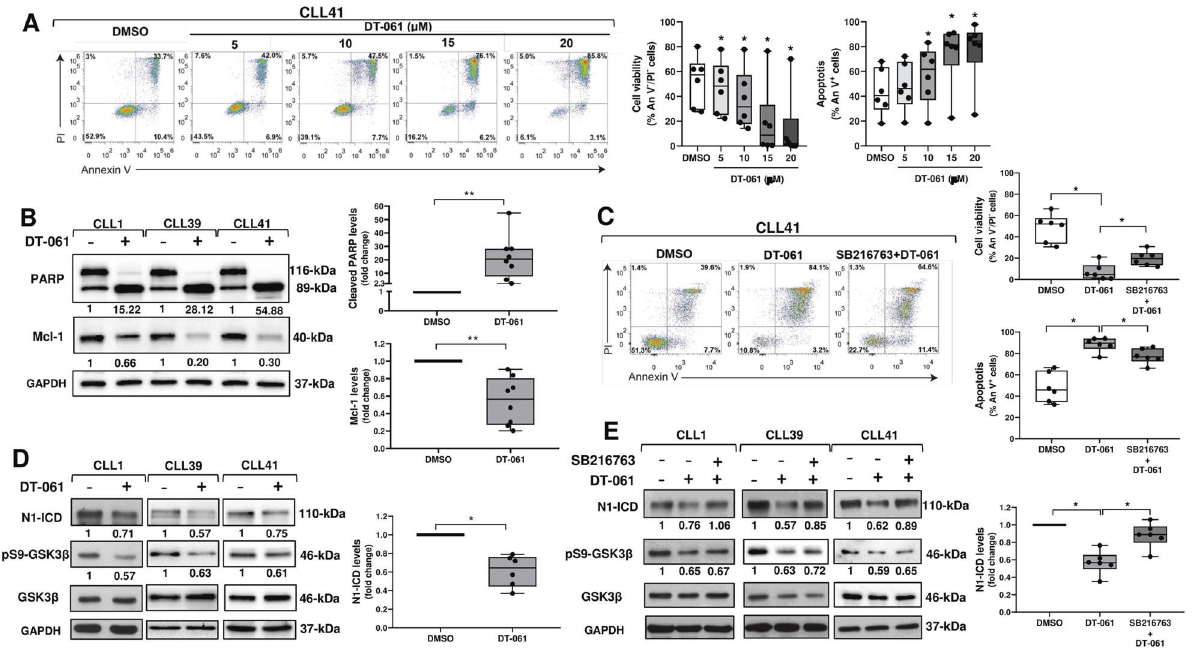
Fig. 6 The PP2A activator DT-061 reduces N1-ICD levels and CLL cell survival in vitro by promoting GSK3 β activity. A CLL cells were treated for 24 h with the indicated concentrations of DT-061 or DMSO as control ( n = 6). Cell viability and apoptosis were evaluated by fl ow cytometric analysis of Annexin V/PI (An V/PI) double staining. Left, results are represented as the percentage of viable (An V - /PI - ), early apoptotic (An V + /PI - ), late apoptotic (An V + /PI + ), and necrotic (An V - /PI + ) cells. One CLL sample is shown. Middle and right, box and whisker plots with data points of the percentage of viable An V - /PI - (middle) and apoptotic An V + (An V + /PI - plus An V + /PI + ) cells (right) are shown. * P < 0.05 according to Wilcoxon paired test. B Western blot analysis of PARP and Mcl-1 was performed in CLL cells cultured for 24 h with 15 μ M DT-061 or DMSO as control ( n = 8). GAPDH was analyzed as loading control. Left, the values under the blots indicate the fold change in cleaved PARP (89-kDa) and Mcl-1 levels in DT-061-treated cells compared with control DMSO (set to 1), normalized to levels of full length PARP (116-kDa) and GAPDH, respectively. Three CLL samples are shown. Right, box and whisker plots with data points of densitometry analysis of cleaved PARP (top panel) and Mcl-1 (bottom panel), represented as fold change compared with control DMSO. ** P < 0.01 according to Wilcoxon paired test. C CLL cells were cultured for 24 h with 15 µM DT-061 as single agent and in combination with 5 µM SB216763, or with DMSO as control ( n = 6). Cell viability and apoptosis data were obtained and represented as in panel A. Left, one CLL sample is shown. Right, box and whisker plots with data points of the percentage of viable An V - /PI - (top panel) and apoptotic An V + (An V + /PI - plus An V + /PI + ) cells (bottom panel) are shown. * P < 0.05 according to Wilcoxon paired test. D Western blot analysis of N1-ICD was performed in CLL cells cultured for 3 h with 15 μ M DT-061 or DMSO as control ( n = 6). GAPDH was analyzed as loading control. The effect of DT-061 on GSK3 β inactivation was assessed by analyzing pS9-GSK3 β levels. Left, the values under the blots indicate the fold change in N1-ICD and pS9-GSK3 β levels in